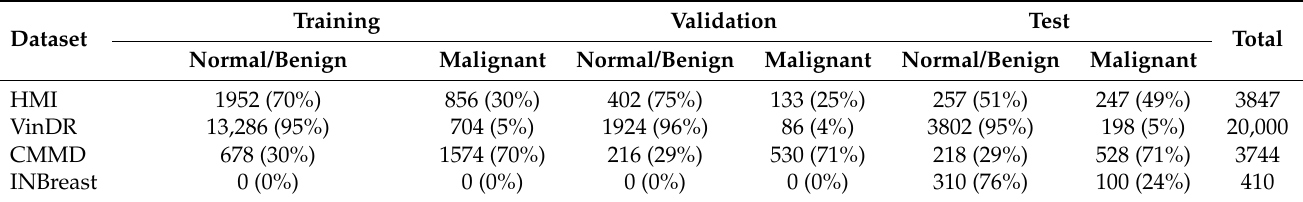
Table 1. Summary of the number of images in each dataset and subset by